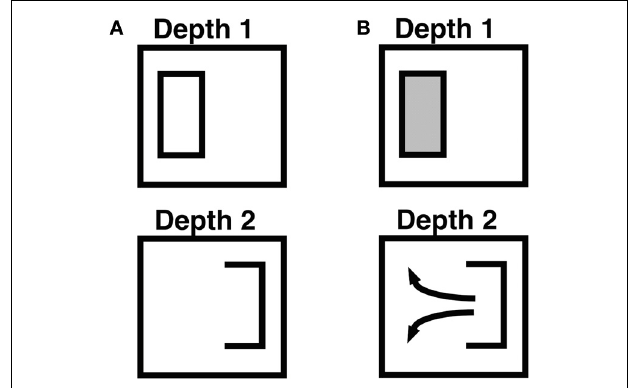
FIGURE 5 | Combining monocular and binocular boundaries, and filling-in within connected boundaries. This figure illustrates how monocular and other depth-unselective boundaries, such as horizontal boundaries, are combined to control surface filling-in. The depicted boundaries, apart from the rectangular boundary frame, represent the boundaries that are induced by a part of an idealized da Vinci stereopsis display in which only the left vertical boundary within the frame is binocularly viewed. See the partially occluded window in Figure 2 of Grossberg (1994) for a complete da Vinci stereopsis display in which this kind of situation can occur. The right vertical boundary within the frame is viewed through only one eye, and is hence a monocular boundary that conveys no disparity information. The horizontal boundaries are processed in the same way as monocular boundaries. (A) Open and connected boundaries that are induced by the display after all boundaries are combined. The left vertical boundary is processed selectively at Depth 1 due to the binocular disparity that it induces. The right vertical boundary and the upper and lower horizontal boundaries are added to all boundary representations, across all depths, along the line of sight. This combination of boundaries creates a closed rectangular boundary at Depth 1 and an open boundary at Depth 2. These boundaries are projected topographically to the Filling-In DOmain, or FIDO, at the corresponding depth within which boundary-modulated filling-in of surface lightnesses and colors occurs. (B) Filling-in of surface lightness is contained or not depending on the connectedness of the boundary. At Depth 1, filling-in is contained within the closed rectangular boundary. At Depth 2, lightness can flow through the boundary gap and become uniform around both sides of the figure’s boundary. As a result, the surface contour representation at Depth 2 generates no output signals via the contrast-sensitive network that outputs to subsequent processing stages. Reproduced with permission from Cao and Grossberg